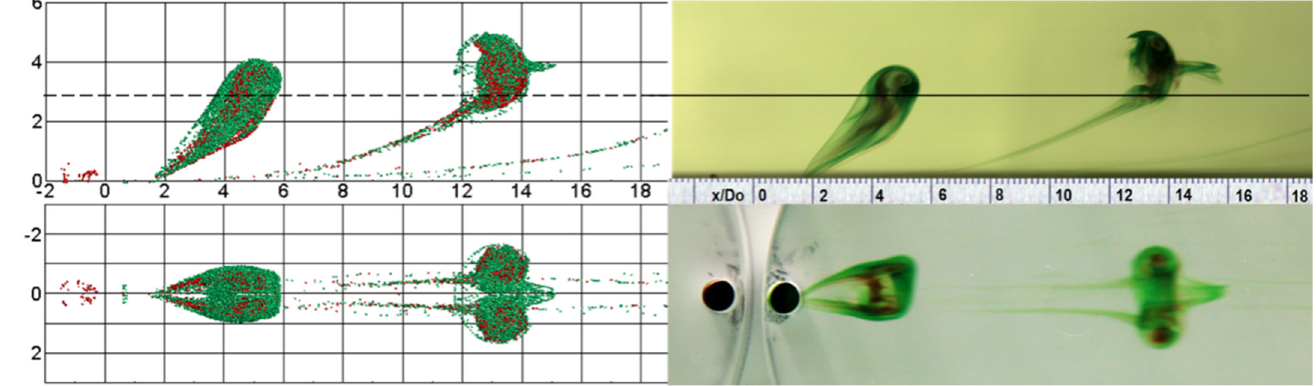
Figure 3. CFD Particle patterns ( left ) and experimental dye visualization ( right ) for the twin SJs at Δ ϕ = π / 2 and t / T = 0.25 (The lines indicate the edge of the boundary layer).